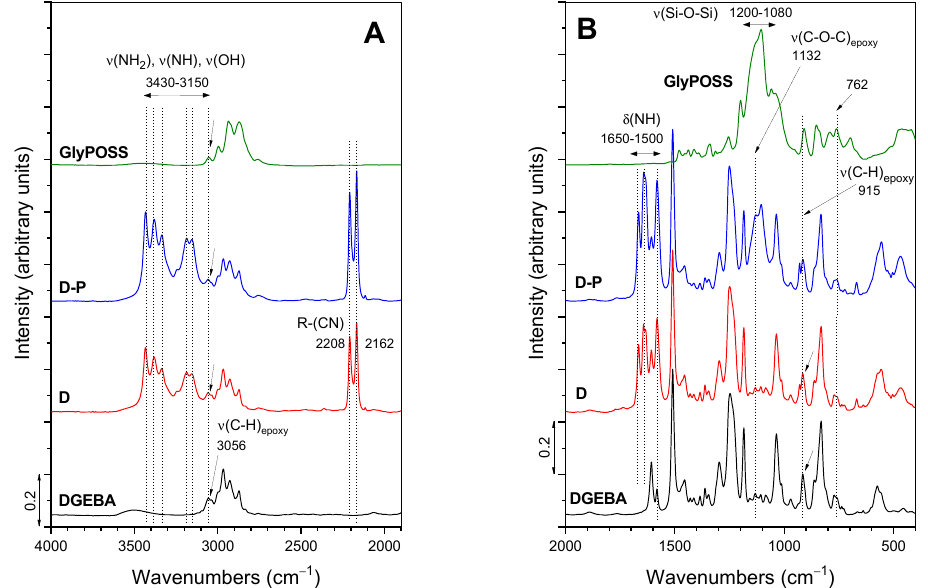
Figure 4. FT-IR absorbance spectra of precursors DGEBA and GlyPOSS, and initial D and D-P formulations in the spectral ranges: ( A ) 4000–1900 cm − 1 and ( B ) 2000–400 cm − 1 .